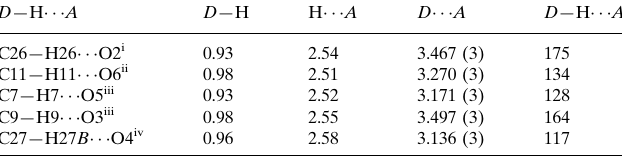
Hydrogen-bond geometry (A˚ , (cid:2)